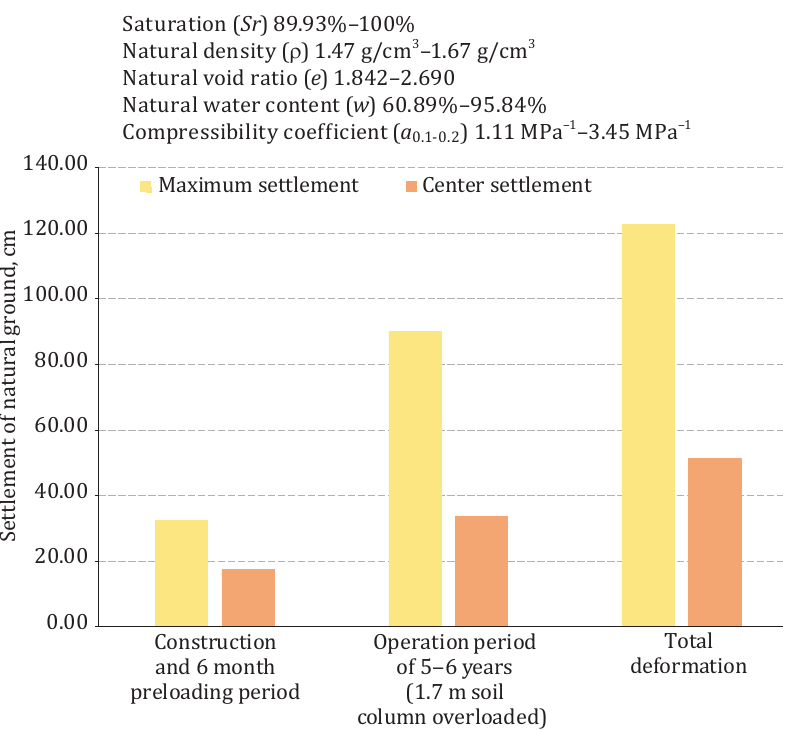
Figure 6. Settlement of natural soft ground obtained at different times from the centrifugal model test (Gan,